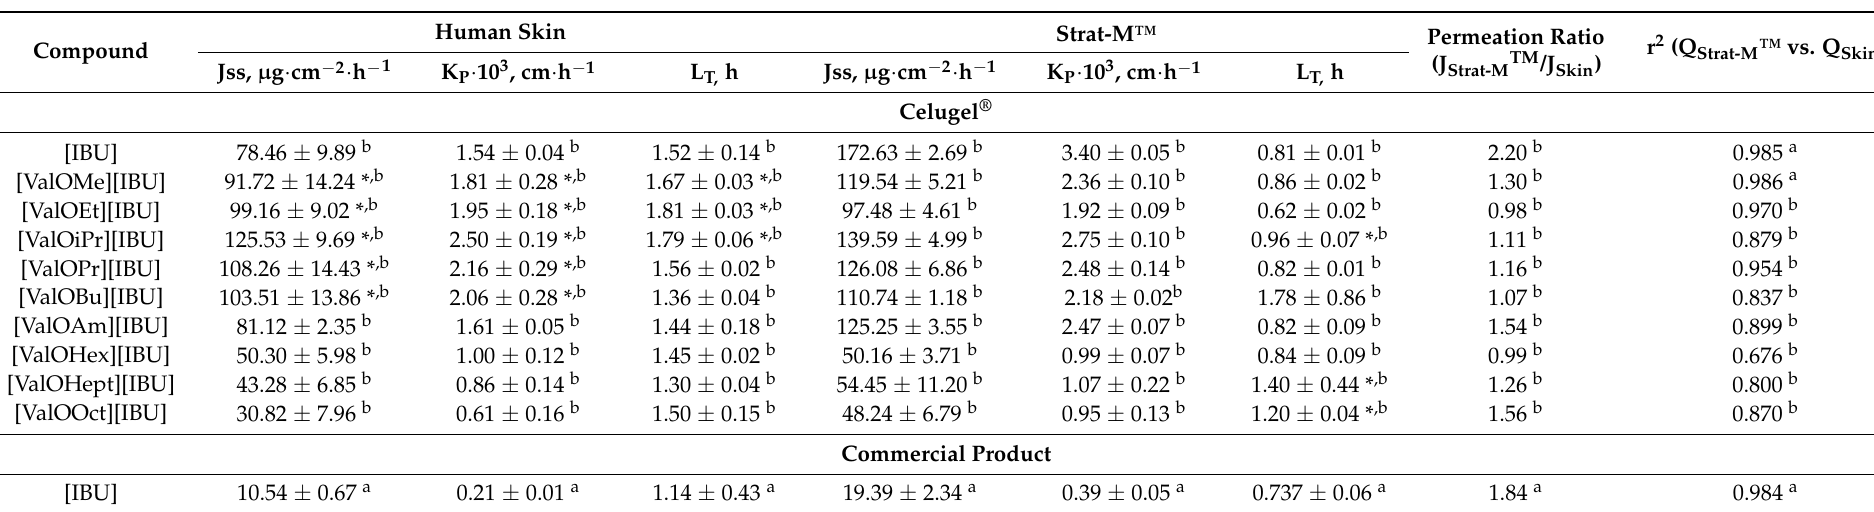
Table 3. Permeation parameters of [IBU] and its modification from Celugel ® formulation through human skin and Strat-M™.